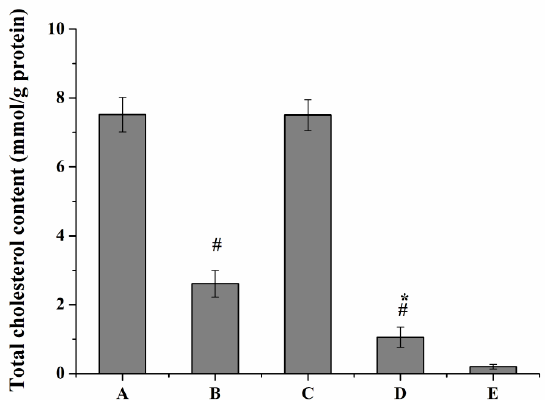
Figure 10. Total cholesterol content of oxLDL-induced macrophages. (A) positive control group; (B) curcumin solutions; (C) blank PS-containing carriers; (D) Cur-mNLCs; (E) negative control group; # p < 0.01, compared with A, * p < 0.05, compared with B. In accordance with Oil Red O staining results, curcumin solutions or Cur-mNLCs markedly reduced oxLDL-induced cholesterol accumulation in macrophages ( p < 0.01 for Group B or D vs . Group A), and Cur-mNLCs exhibited more potent effects than curcumin solutions ( p < 0.05 for Group D vs . Group B). PS did not have an obvious effect on macrophages’ lipid uptake behavior ( p > 0.05 for Group C vs . Group A) (mean ± SD, n = 6).